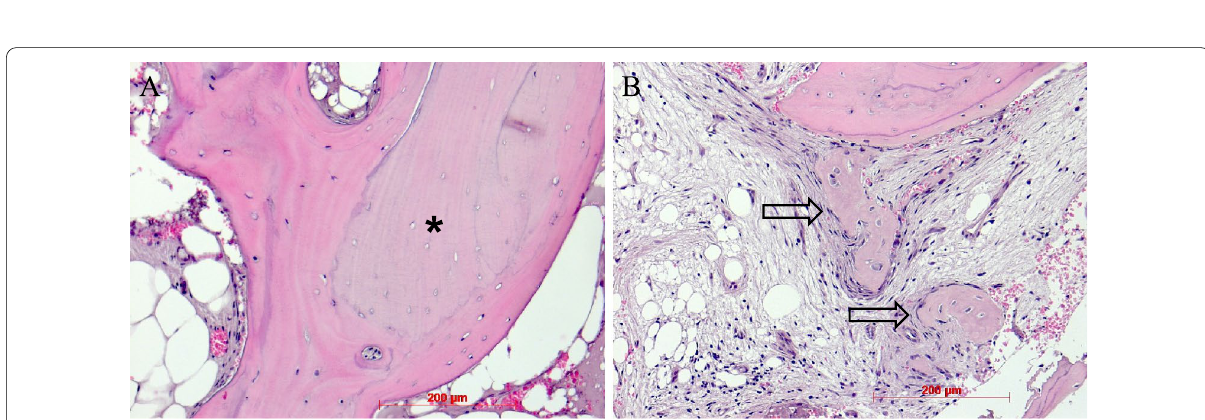
Fig. 10 Newly formed cancellous lamellar bone, embedded allogenous remnant (black asterisk), HE staining, original magnification Ongoing membranaceous osteogenesis, osteoblast covering (arrows), HE staining, original magnification